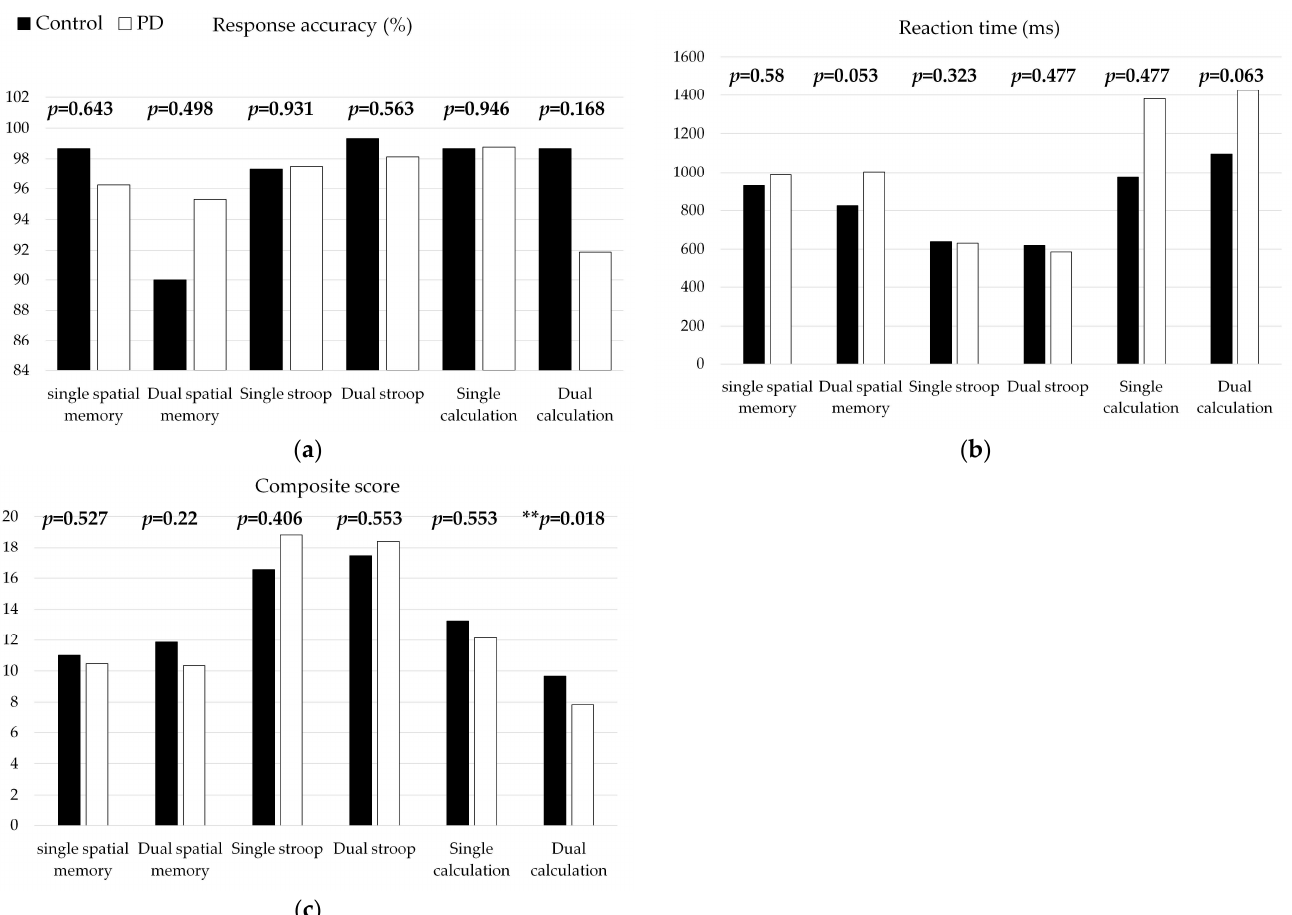
Figure 4. The cognitive performance includes ( a ) Response accuracy, ( b ) Reaction time, and ( c ) composite score, under the group single and dual tasks between healthy and PD group. ** p < 0.05.